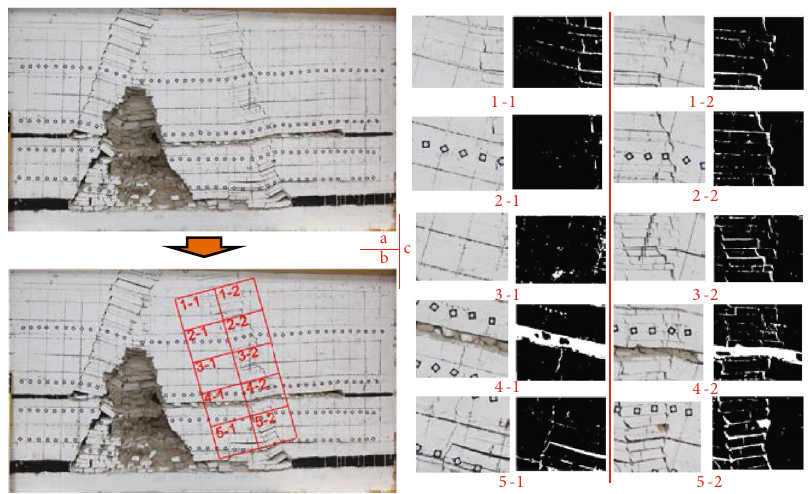
Figure 6: Meshing image of overlying strata. (a) Original picture. (b) Mesh distribution. (c) Mesh after